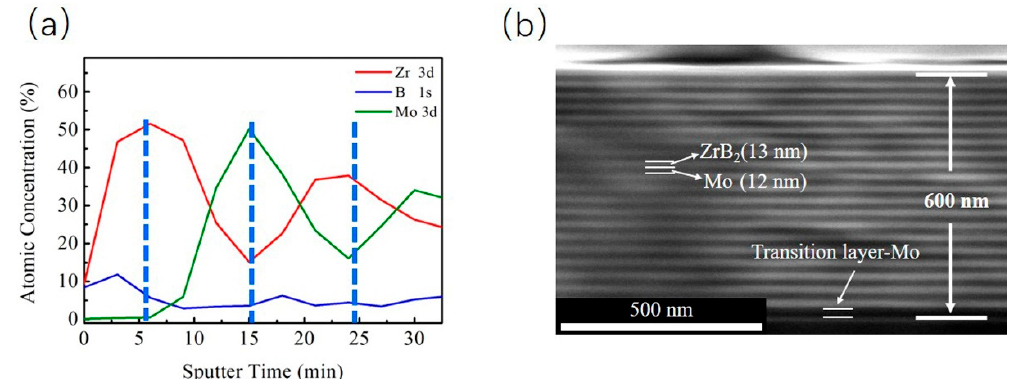
Figure 5. The relationship between the atomic concentration and the stripping time ( a ) and the cross-sectional SEM image ( b ) of the ZrB 2 /Mo multilayers with t ZrB2 :t Mo = 1:1. ( b ) of the ZrB 2 /Mo multilayers with t ZrB2 : t Mo =